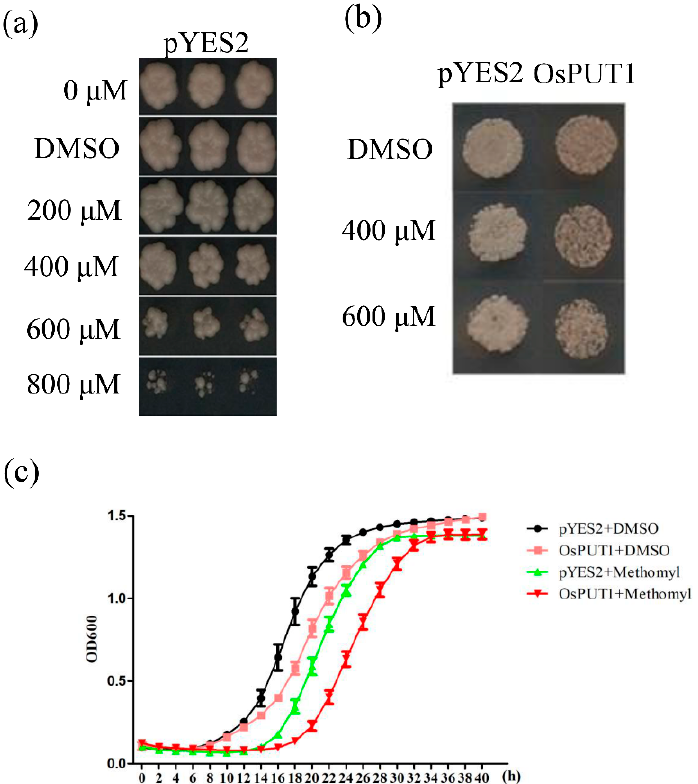
Figure 4. Yeast screens in the presence of different concentrations of methomyl and growth inhibition curves. ( a ) Growth inhibition of pYES2-empty-transformed yeast in media that included different concentrations of methomyl. ( b ) Growth inhibition of yeast expressing pYES2 and OsPUT1 in the presence of 400 µ M and 600 µ M methomyl. ( c ) Growth of pYES2- and OsPUT1 -transformed yeast in synthetic dropout liquid media supplemented with 2% galactose (SD-gal) containing 600 µ M methomyl; media that included dimethyl sulfoxide (DMSO) served as a control. The OD 600 of the culture was recorded every 2 h for 40 h. The data are presented as the means ± standard deviations ( n =